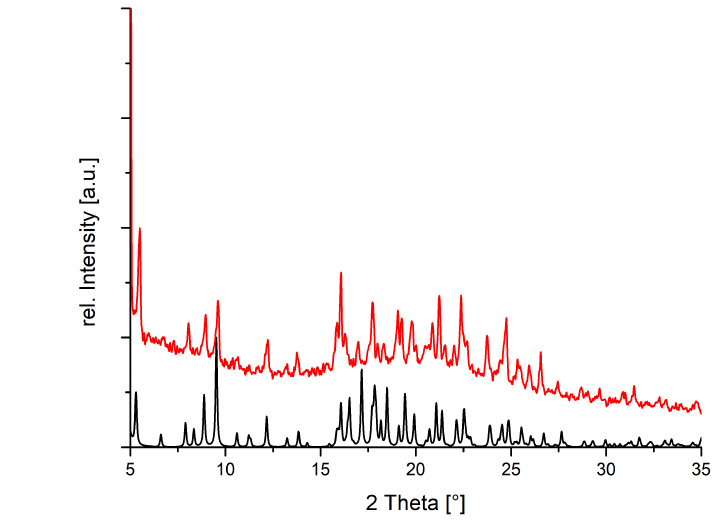
Figure 13. Measured (red) and calculated (black) powder diffraction pattern for compound 3b